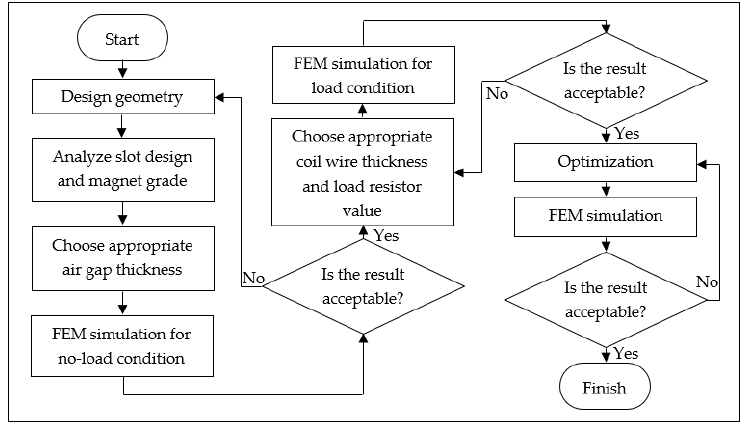
Figure 2. Electromagnetic generator design flowchart.